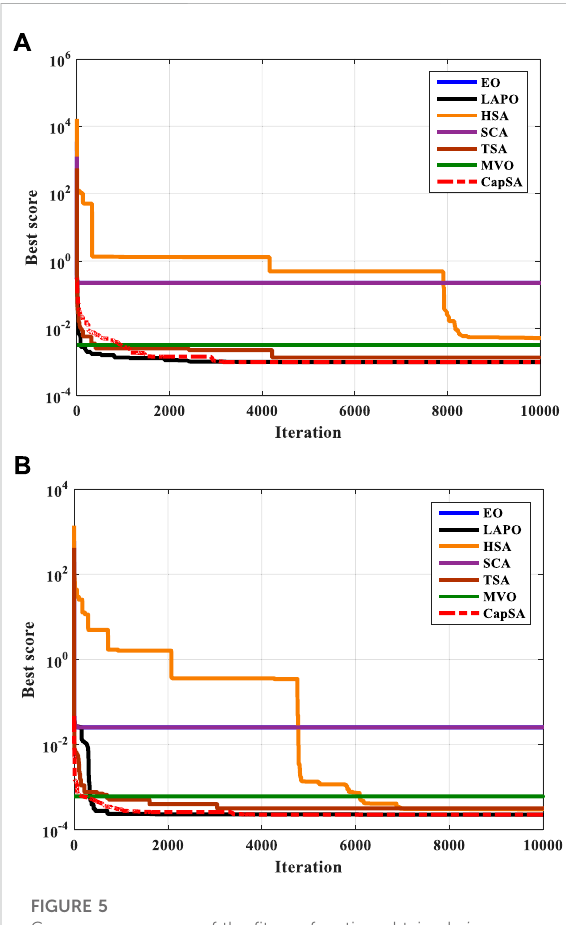
FIGURE 5 Convergence curves of the fi tness function obtained via different optimizers. (A) R.T.C France cell and (B) PVW752